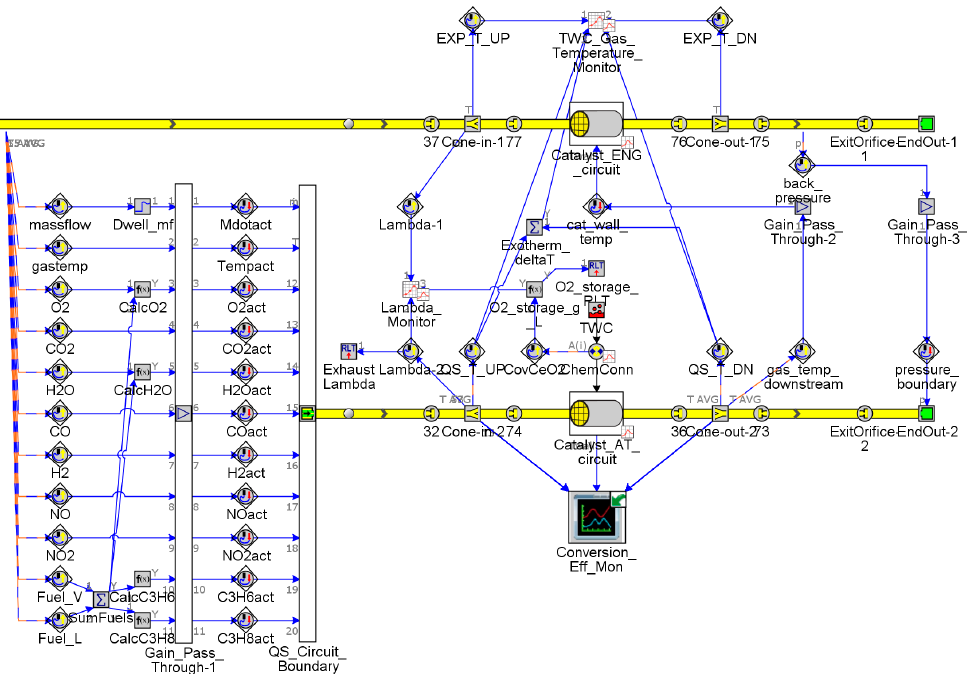
Figure 2. Model of the aftertreatment.